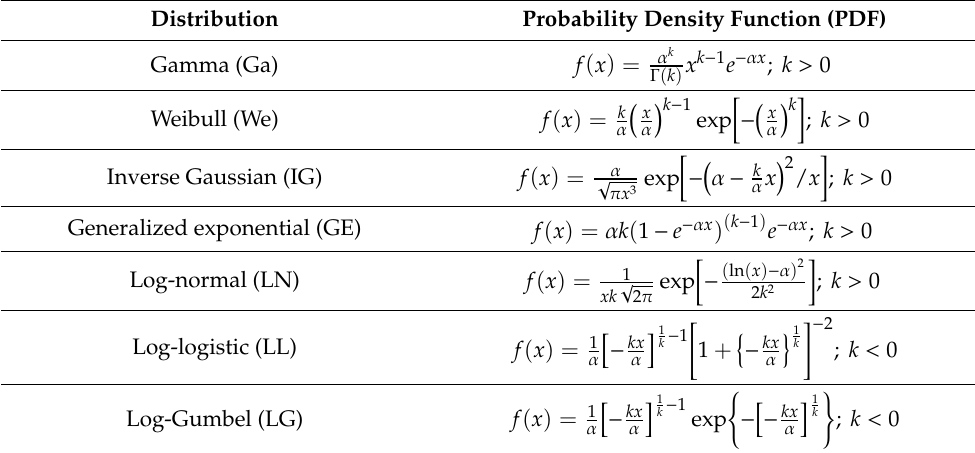
Table 1. Probability density functions used in the